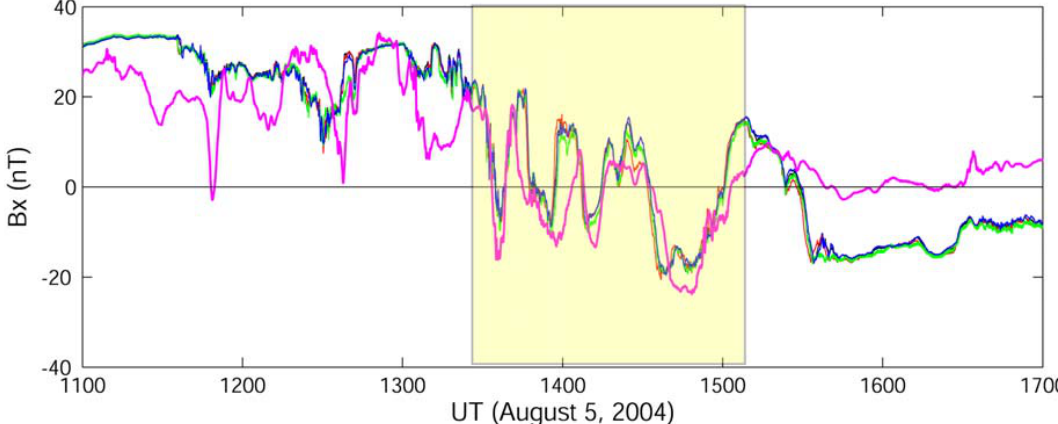
Fig. 2. Comparison of the Bx components of the magnetic field observed by Cluster and TC-1. The thick magenta line is the TC-1. The shaded region indicates the eight neutral crossings to be studied in detail.